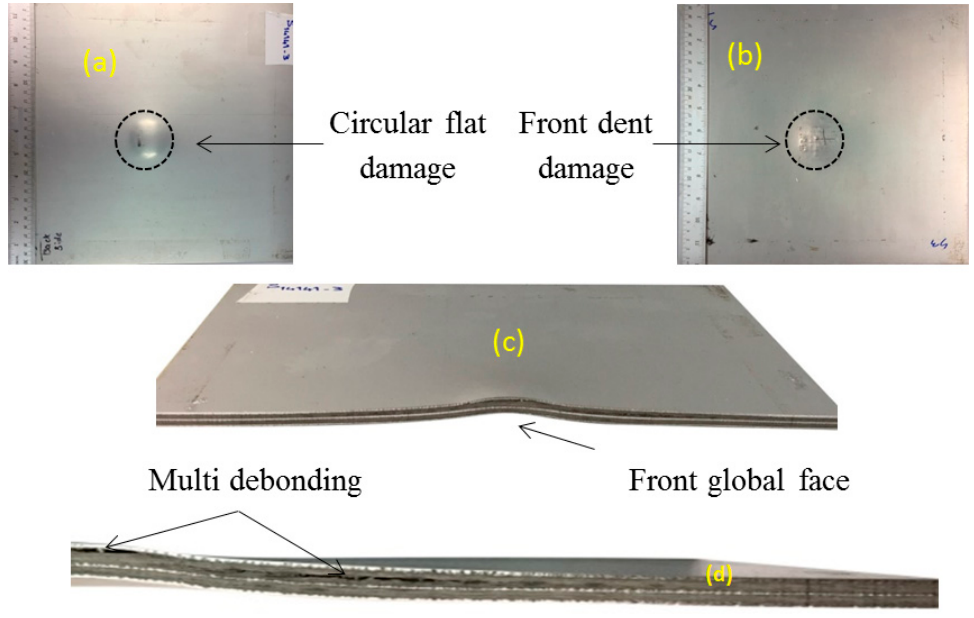
Figure8. SamplecodeS14141-3subjectedtoimpulse14.7N.s( a )backface, ( b )frontface, ( c )cross-section, ( d ) half Figure 8. Sample code S14141-3 subjected to impulse 14.7 N.s ( a ) back face, ( b ) front face, ( c ) cross-section, ( d ) half cross-section.